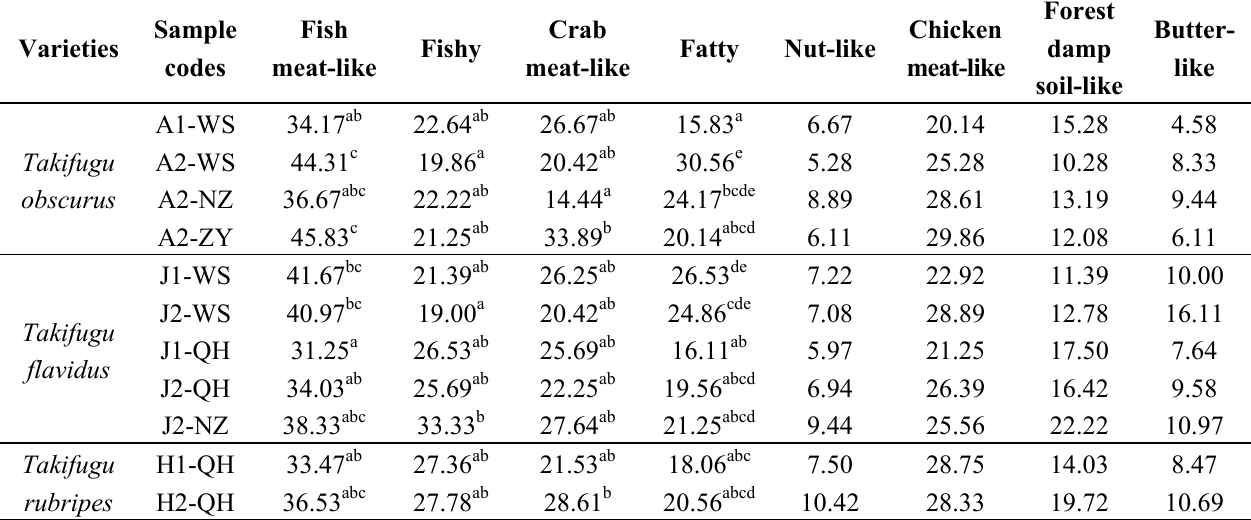
Table 3. Means for olfactory sensory evaluation of puffer fish samples.